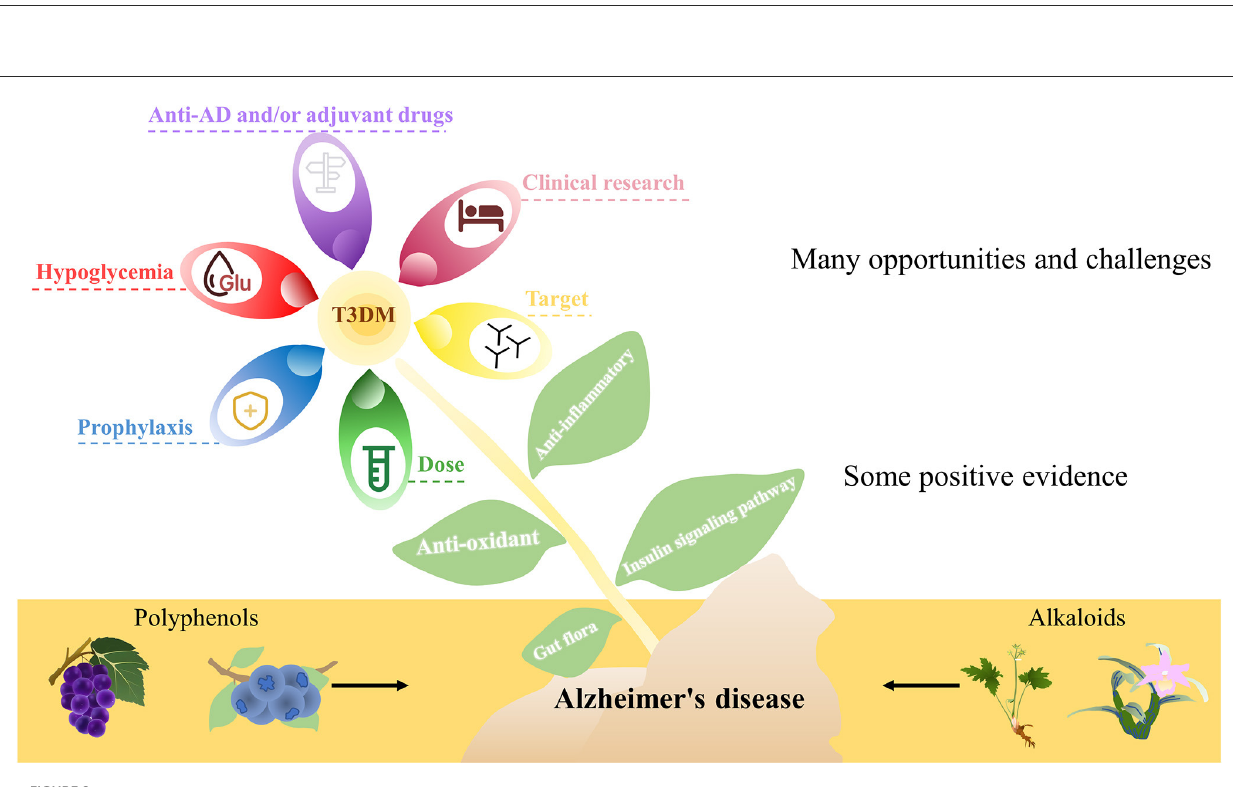
at some patients with AD, especially for some patients with AD with hyperglycemia as the early manifestation or with